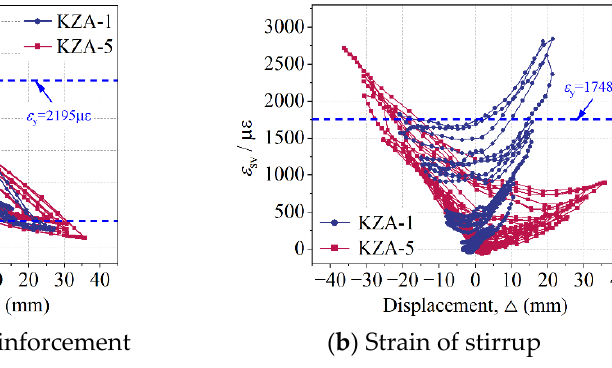
Figure 7. Strain of reinforcement.